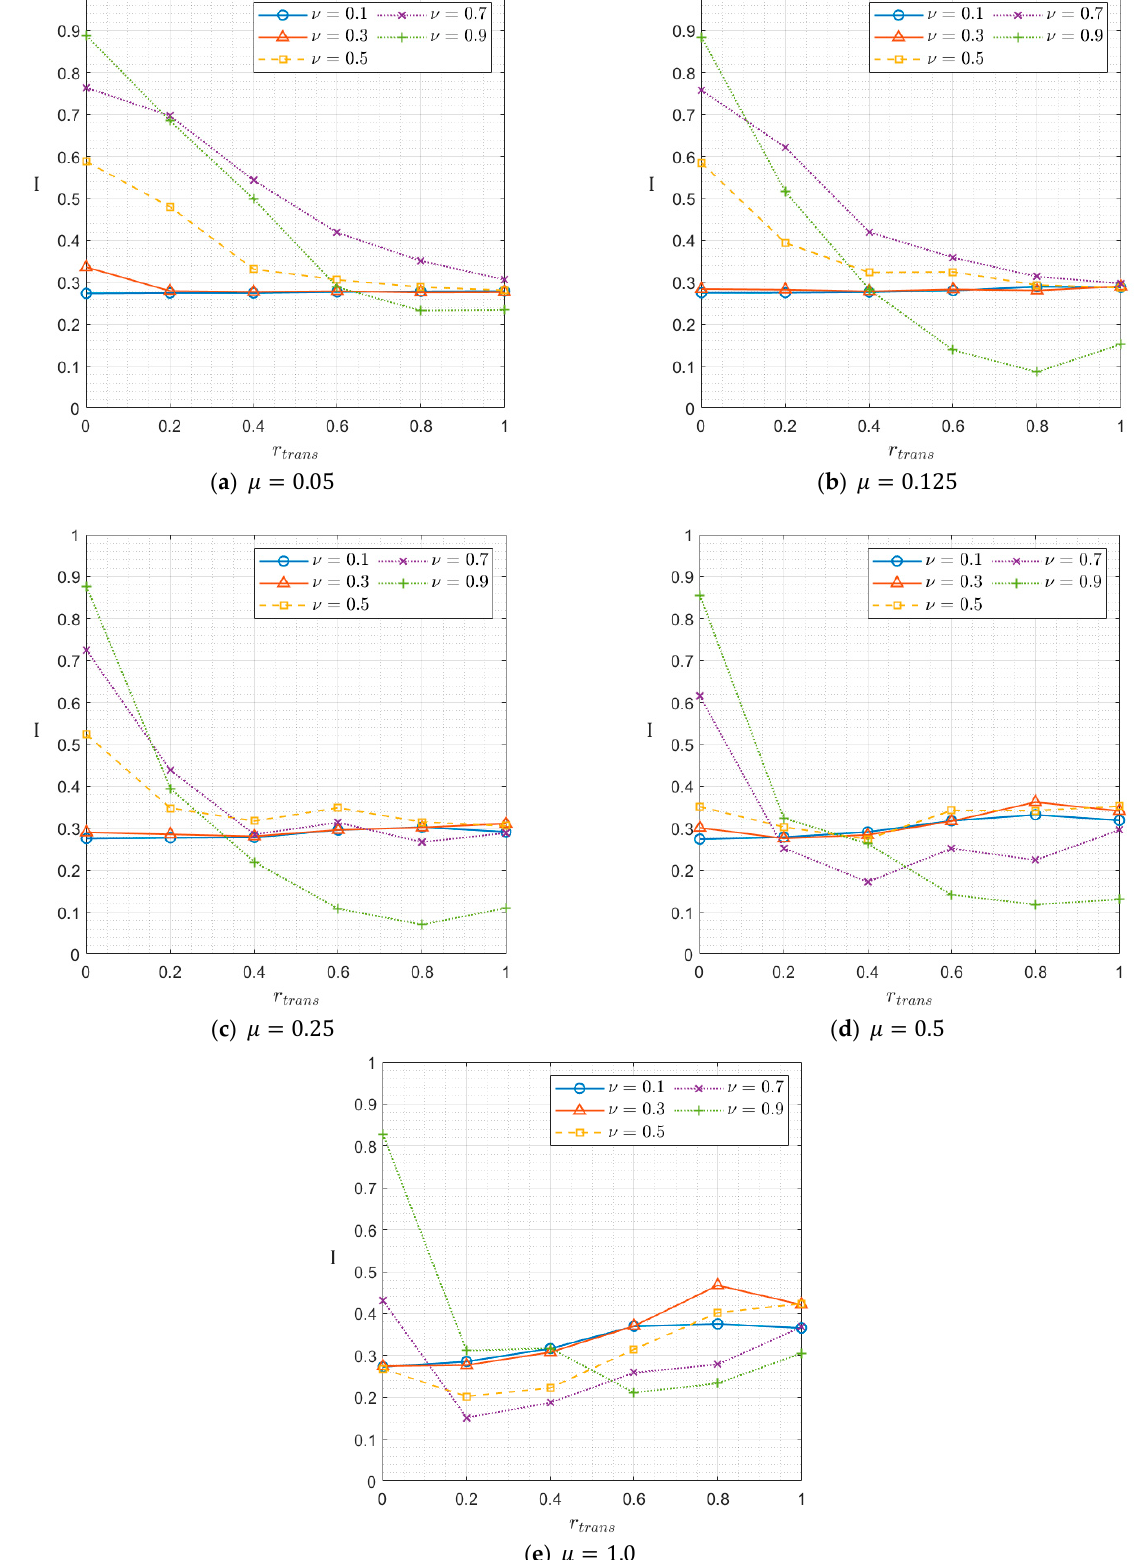
Figure 6. The effect of the transition time ( r trans ) and fixed vortex centre ( ν ) on mixing performance ( I ) with fixed total time of 10, which indicates that ( a ) iterations are 200; ( b ) 80; ( c ) 40; ( d ) 20; and ( e ) 10 with different periods ( µ ). Note that Figure 6e is identical to Figure